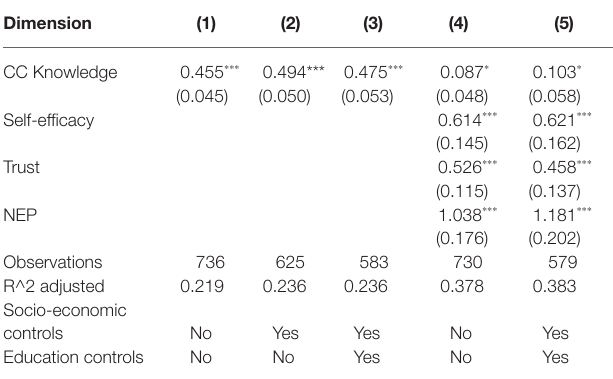
TABLE 5 | Results PCA Nicaragua.